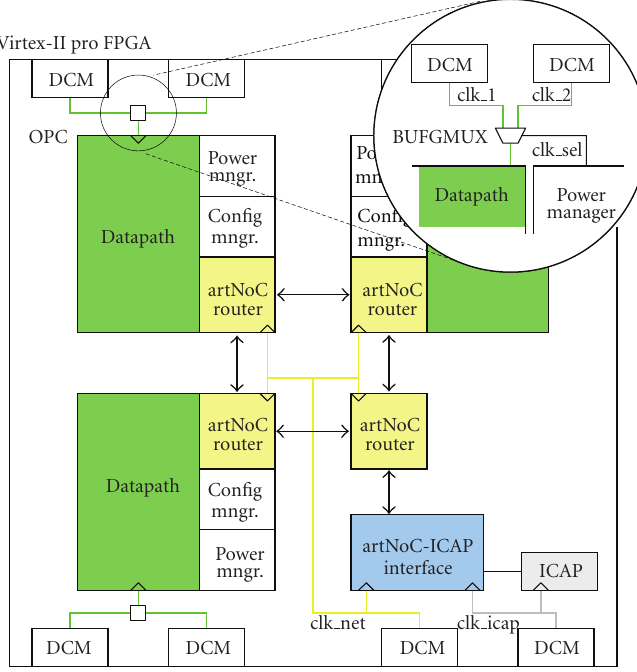
Figure 4: DodOrg FPGA floor plan/clock